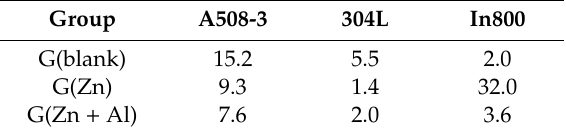
Table 6. The R F values of passive films formed on di ff erent materials with di ff erent treatment methods.